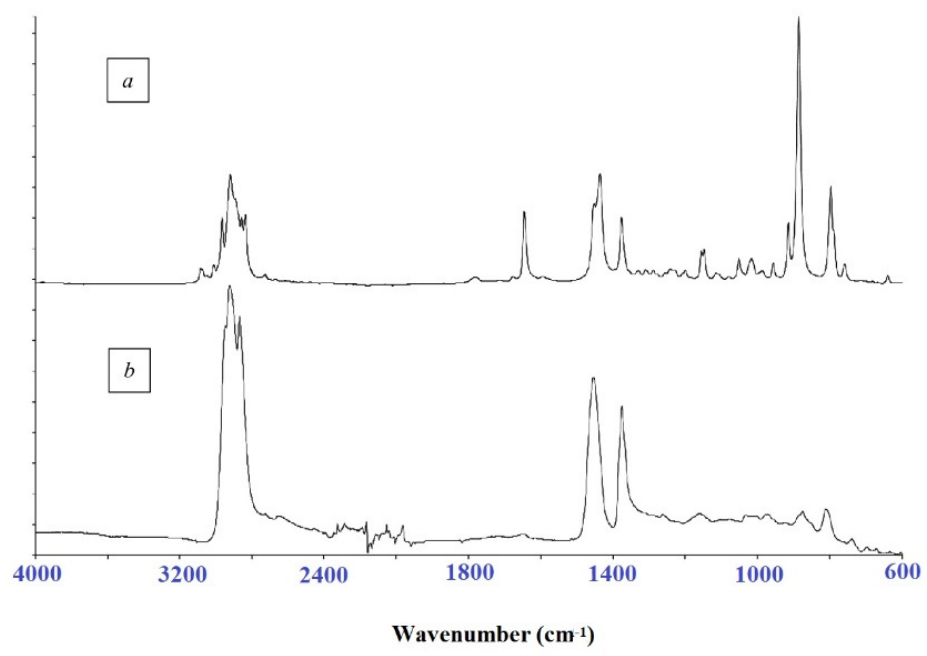
Figure 6. The FTIR spectrum of limonene ( a ) and cationic homopolymerization product ( b ).